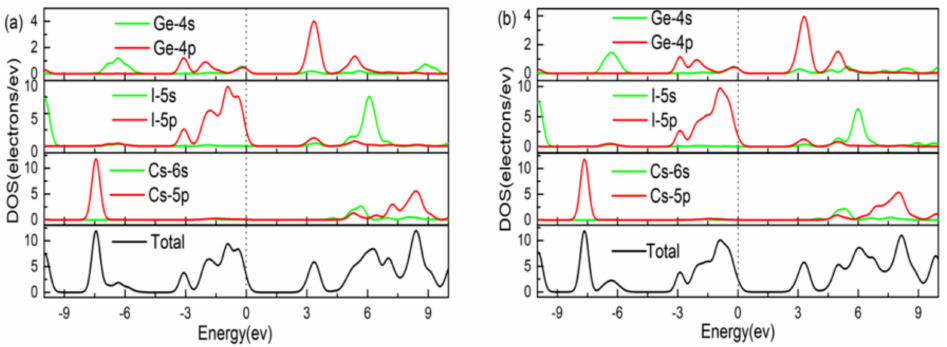
Figure 5. The DOS of CsGeI 3 under the pressure of ( a ) 0 GPa and ( b ) − 0.5